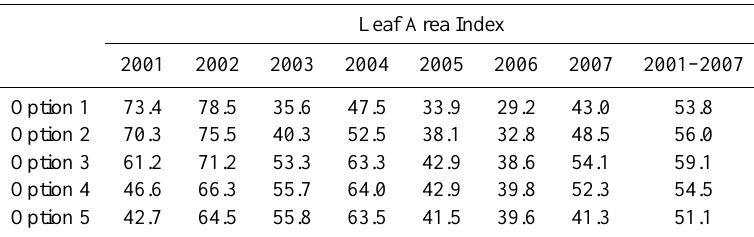
Table 2. The impact (given in %) on LAI of the assimilation in the five experiments used in this study, year by year and for the 7-year period (2001–2007) for the SMOSREX grassland.